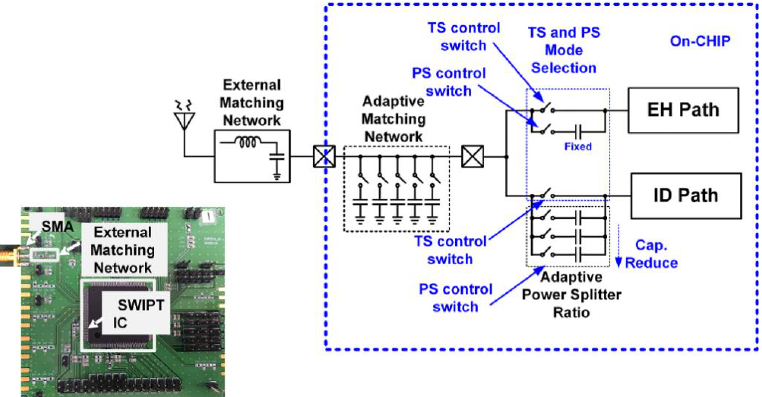
Figure 19. RF power transfer and matching network.